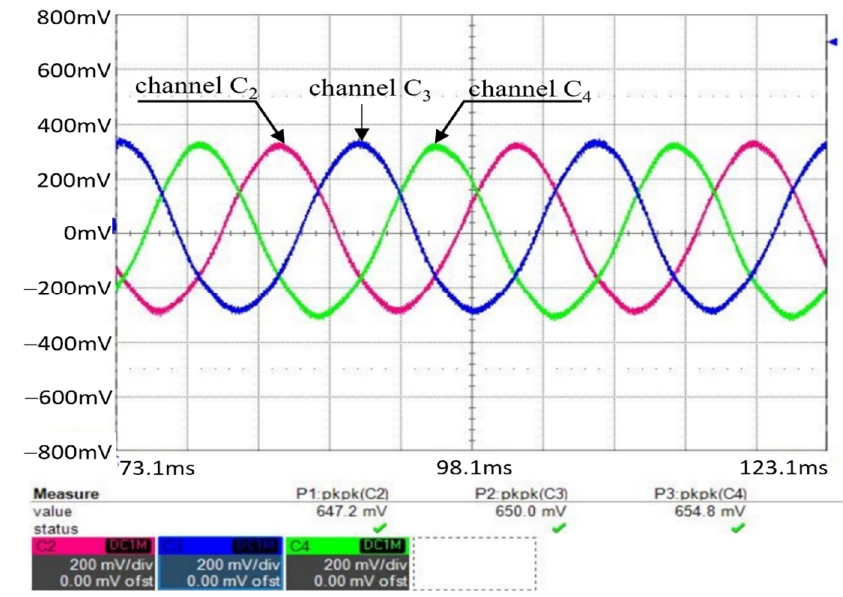
Figure 16. Three-phase output current waveforms of the micro inverter in PQ control experiment.